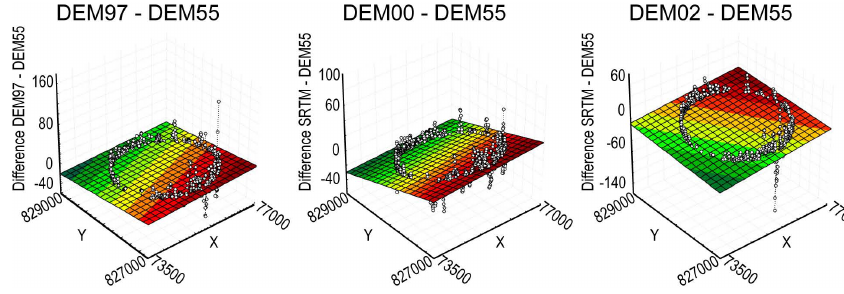
Fig. 3. Difference between DEMs plotted along X and Y .